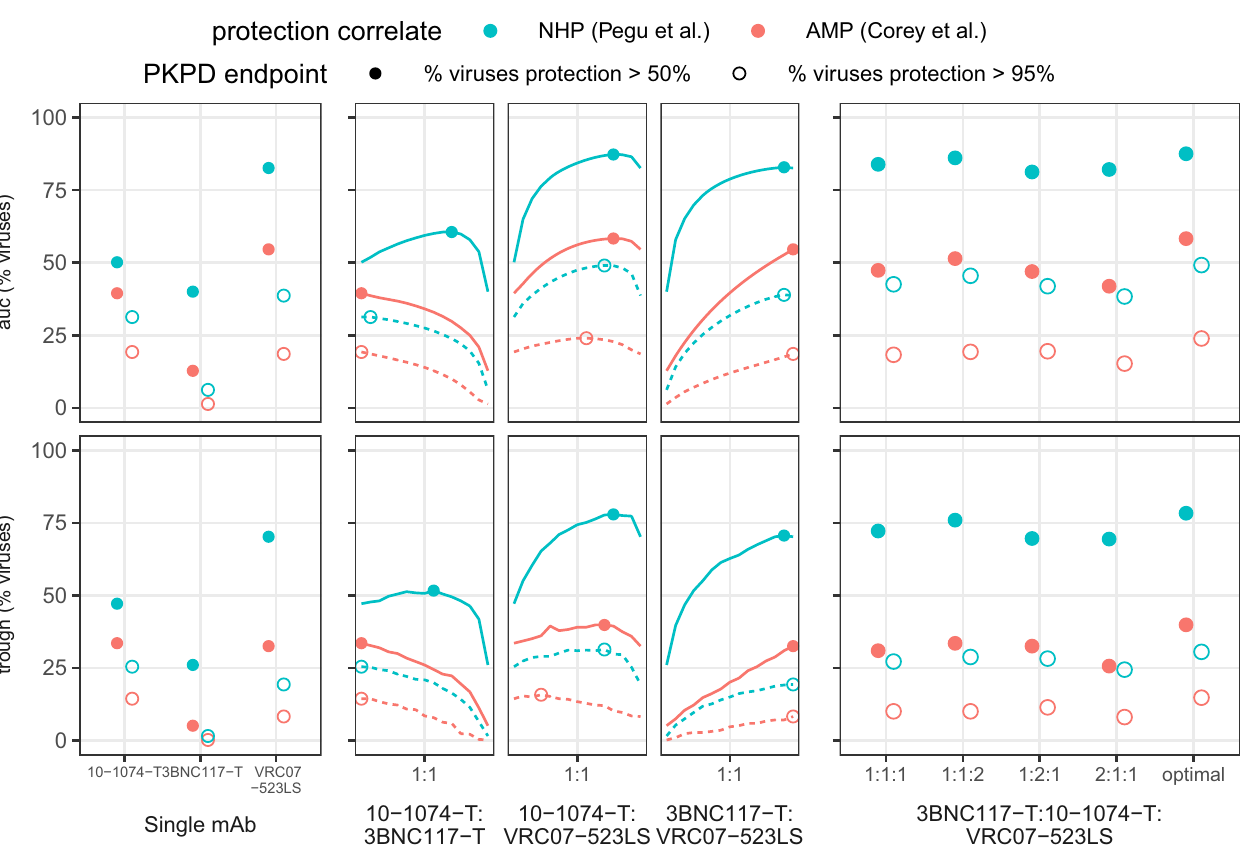
Fig 5. Additional enhancement after optimization of 3-drug therapy. Using 3 well known anti-HIV broadly neutralizing antibodies, we performed an analysis predicting the percent of viruses covered at more than 50% and 95% protection levels using protection correlates from an NHP meta-analysis(14) and the AMP clinical trials(5). The percent viruses covered were computed over the total time course using area under the curve (auc) and at the final time point (trough). We compared coverage for the bNAbs individually, in dual combination, and in triplicate as 1:1:1, 1:1:2, 1:2:1, 2:1:1, and the optimal combination (see S2 Table ). Enhancement over the best single bNAb (VRC07-523-LS) is generated through combinations when evaluating the percent of the viruses neutralized at a 95% level. However, triple drug therapy does not meaningfully enhance over optimized 2-drug therapy levels, even when completely optimized. Protection levels are more optimistically predicted using the NHP meta-analysis vs. the AMP trials (see also S3 Fig ), and optimal designs can depend on the underlying protection correlate (e.g., 10-1074-T:VRC07-523LS auc). Indeed, a 1:1:1 3 drug therapy is outperformed by the optimized 2-drug therapy, highlighting the need to carefully perform case-studies for any optimization